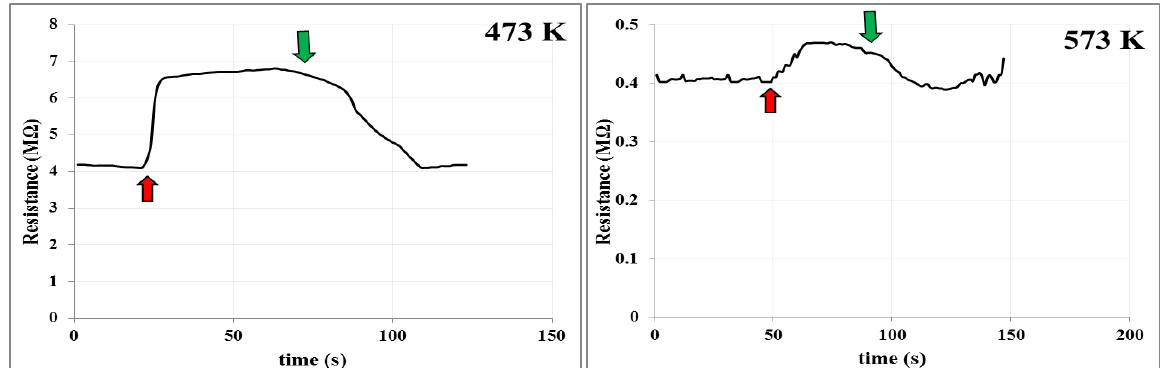
sample when opening and closing of 5% NO 2